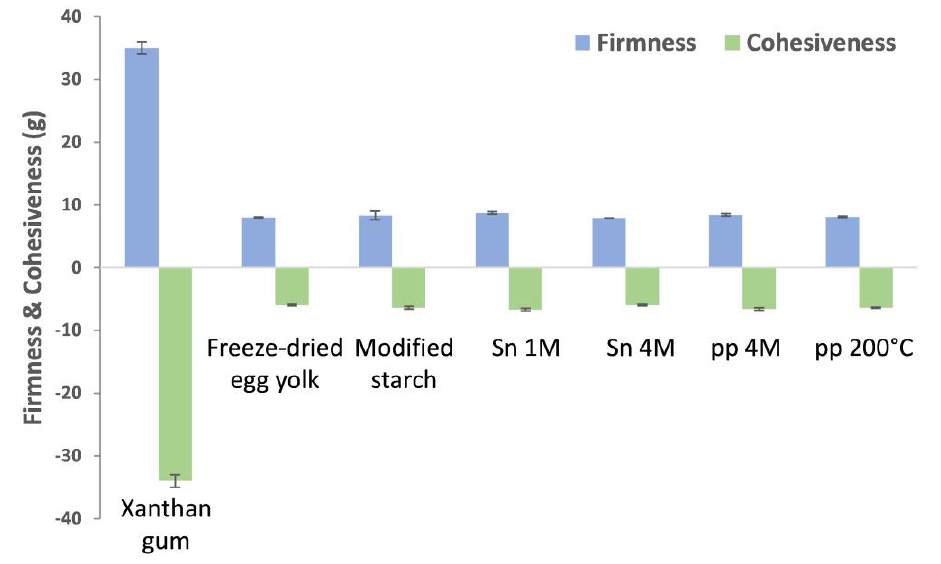
Figure 4. Firmness and cohesiveness of xanthan gum, freeze-dried yolk, modified starch, Sn 1M, Sn 4M, pp 4M, and pp 200 ◦ C, at a concentration of 2.5 mg/mL, in a mayonnaise emulsion model prepared with ultraturrax (13,500 rpm).